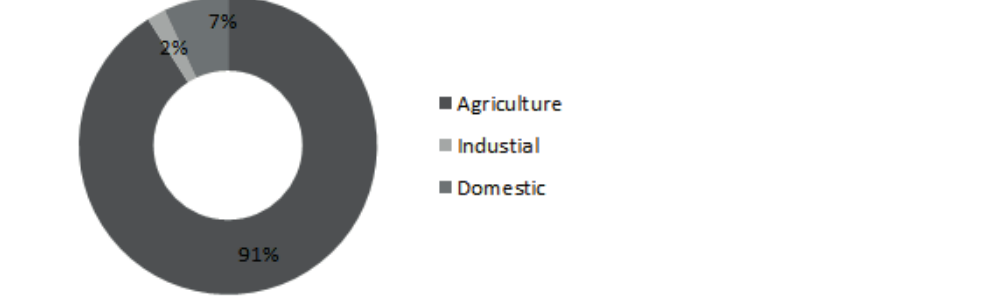
Fig. 2 The water demand requirements by sector for EAB basin (MoI